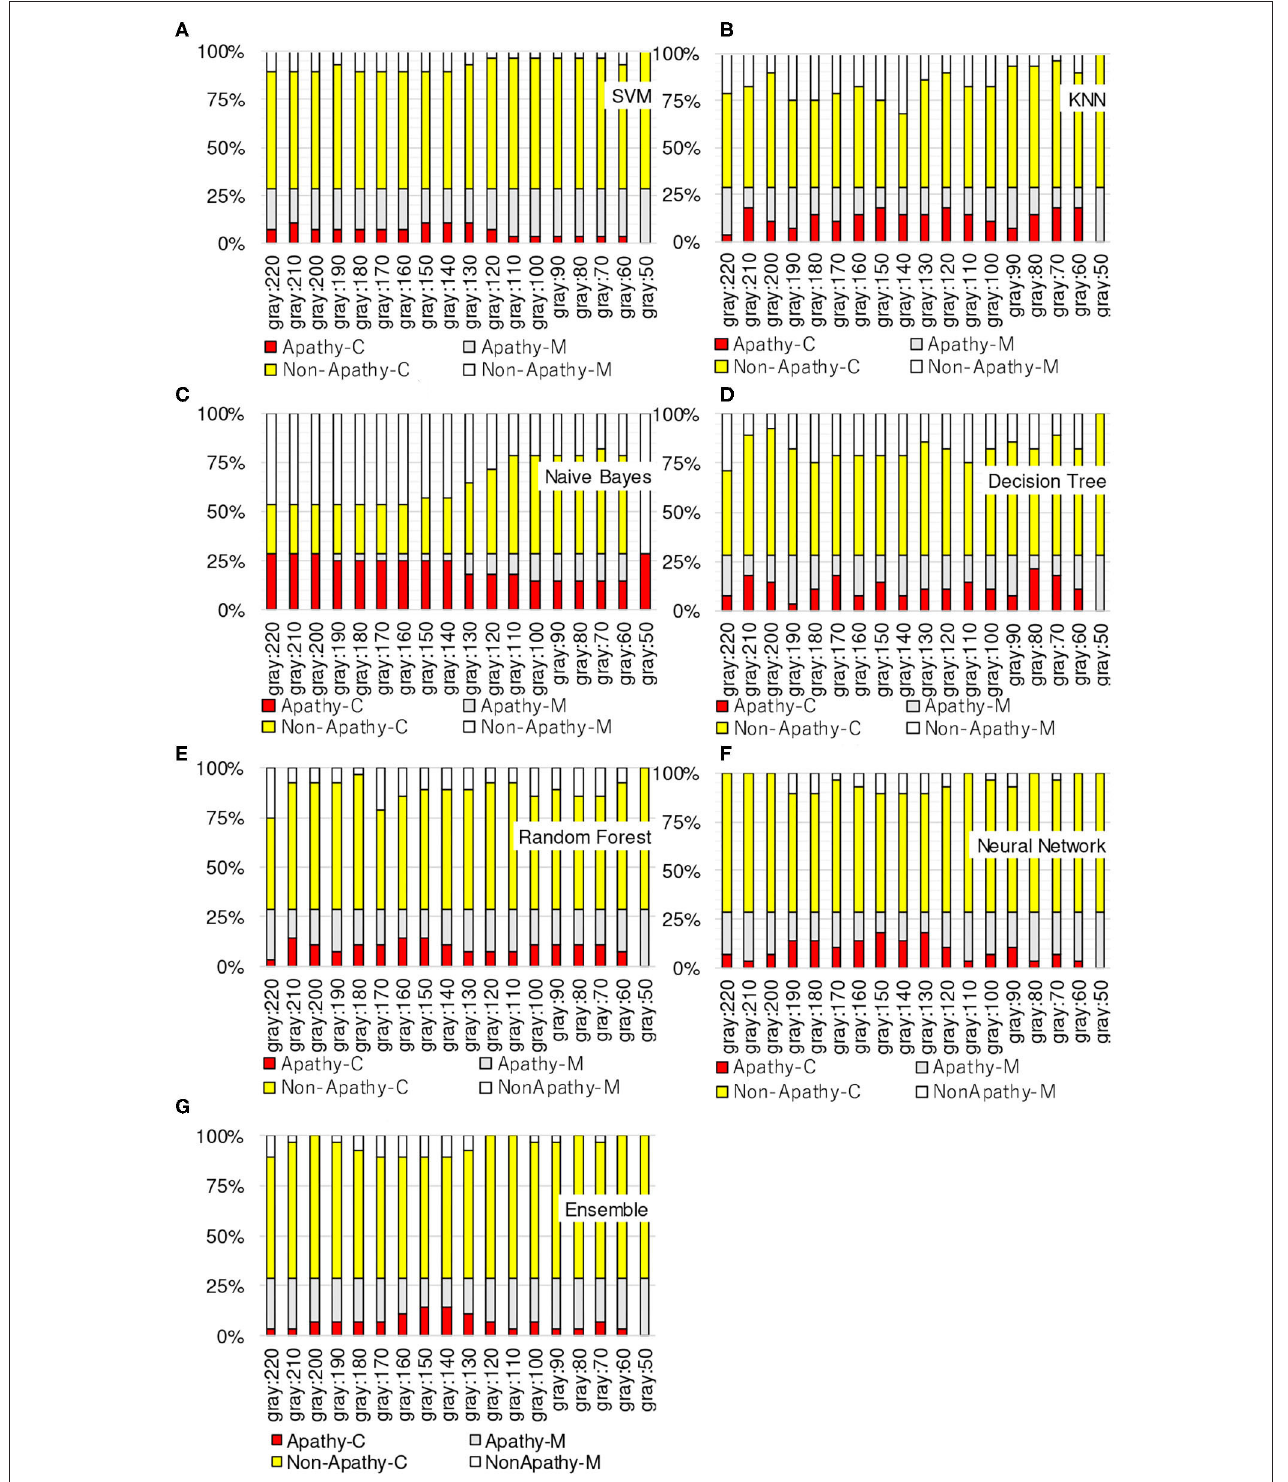
FIGURE 6 | Experimental results: using Y of YUV. (A) SVM, (B) KNN, (C) Naive Bayes, (D) decision tree, (E) random forest, (F) neural network, (G) ensemble.